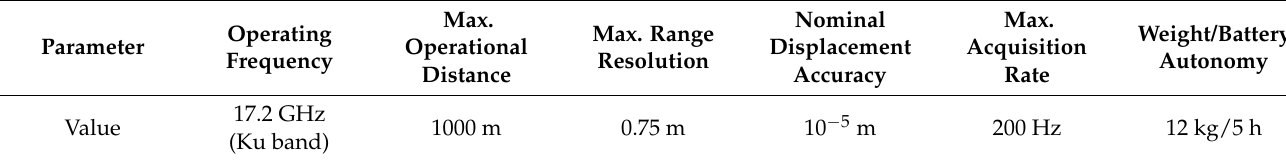
Table 2. Main IBIS radar